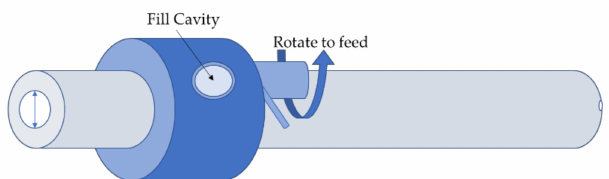
Figure 1. Schematic diagram of the Rack showing the fill cavity and the rotation mechanism to feed into the tube adopted with permission from [14], Elsevier, 2004.